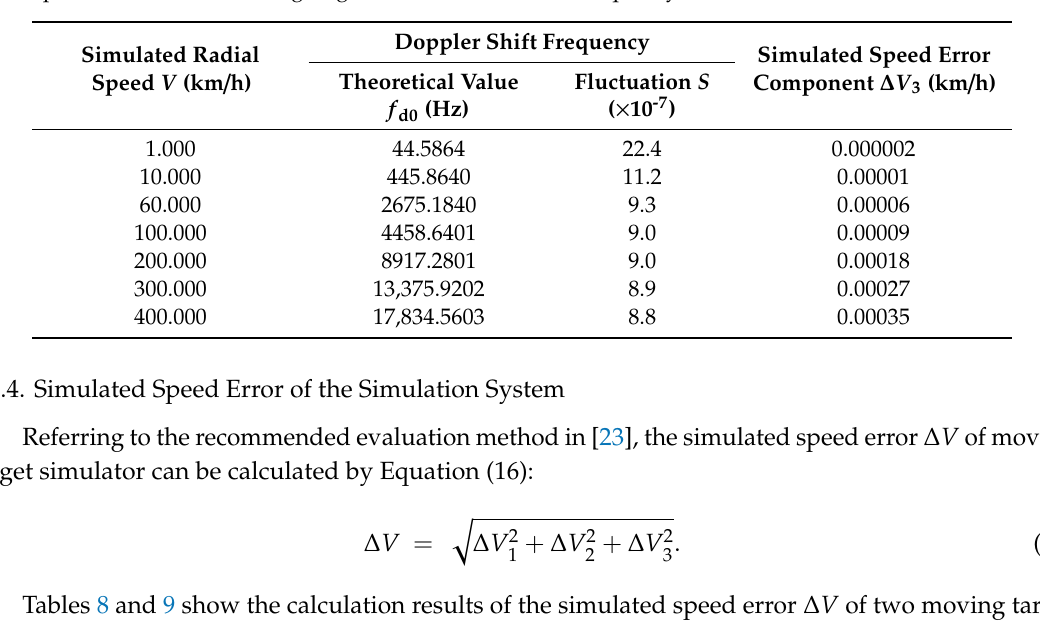
Table 7. Doppler shift frequency fluctuation and simulated speed error component in the fluctuation aspect of the second moving target simulator at emitted frequency of 24,060